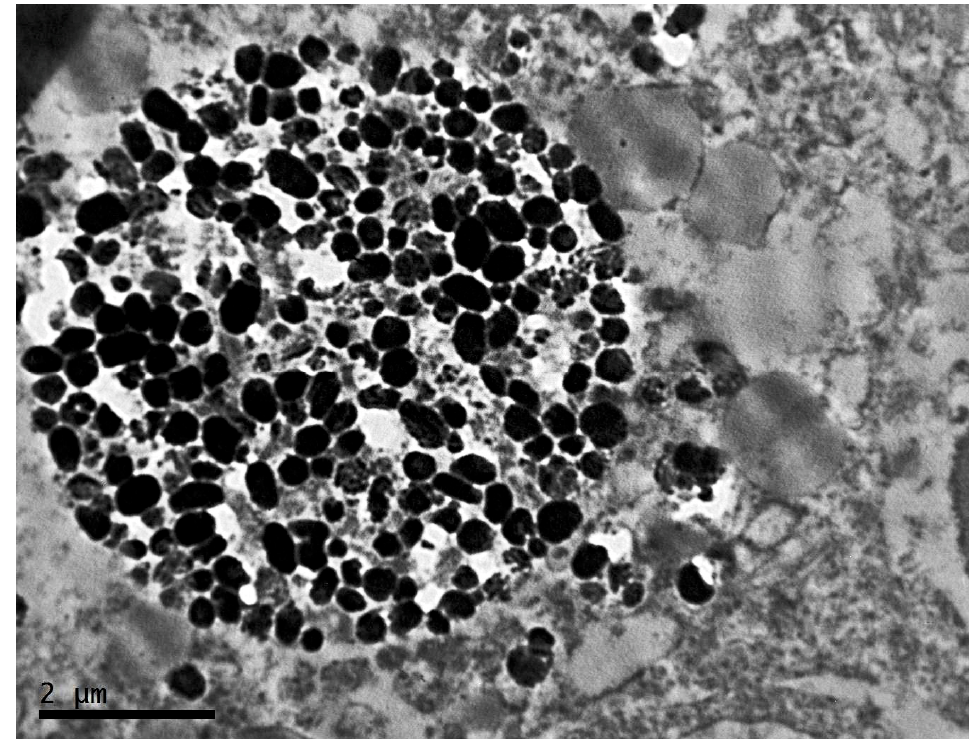
Figure 4. Spherical melanosome complex in cell of transplantable malignant melanoma B16 under the influence of fixed light regime. TEM, ×14,000. In some areas of the sample, both the presence of apoptotic bodies and cases of necrotic cell death are observed (Figure 5).